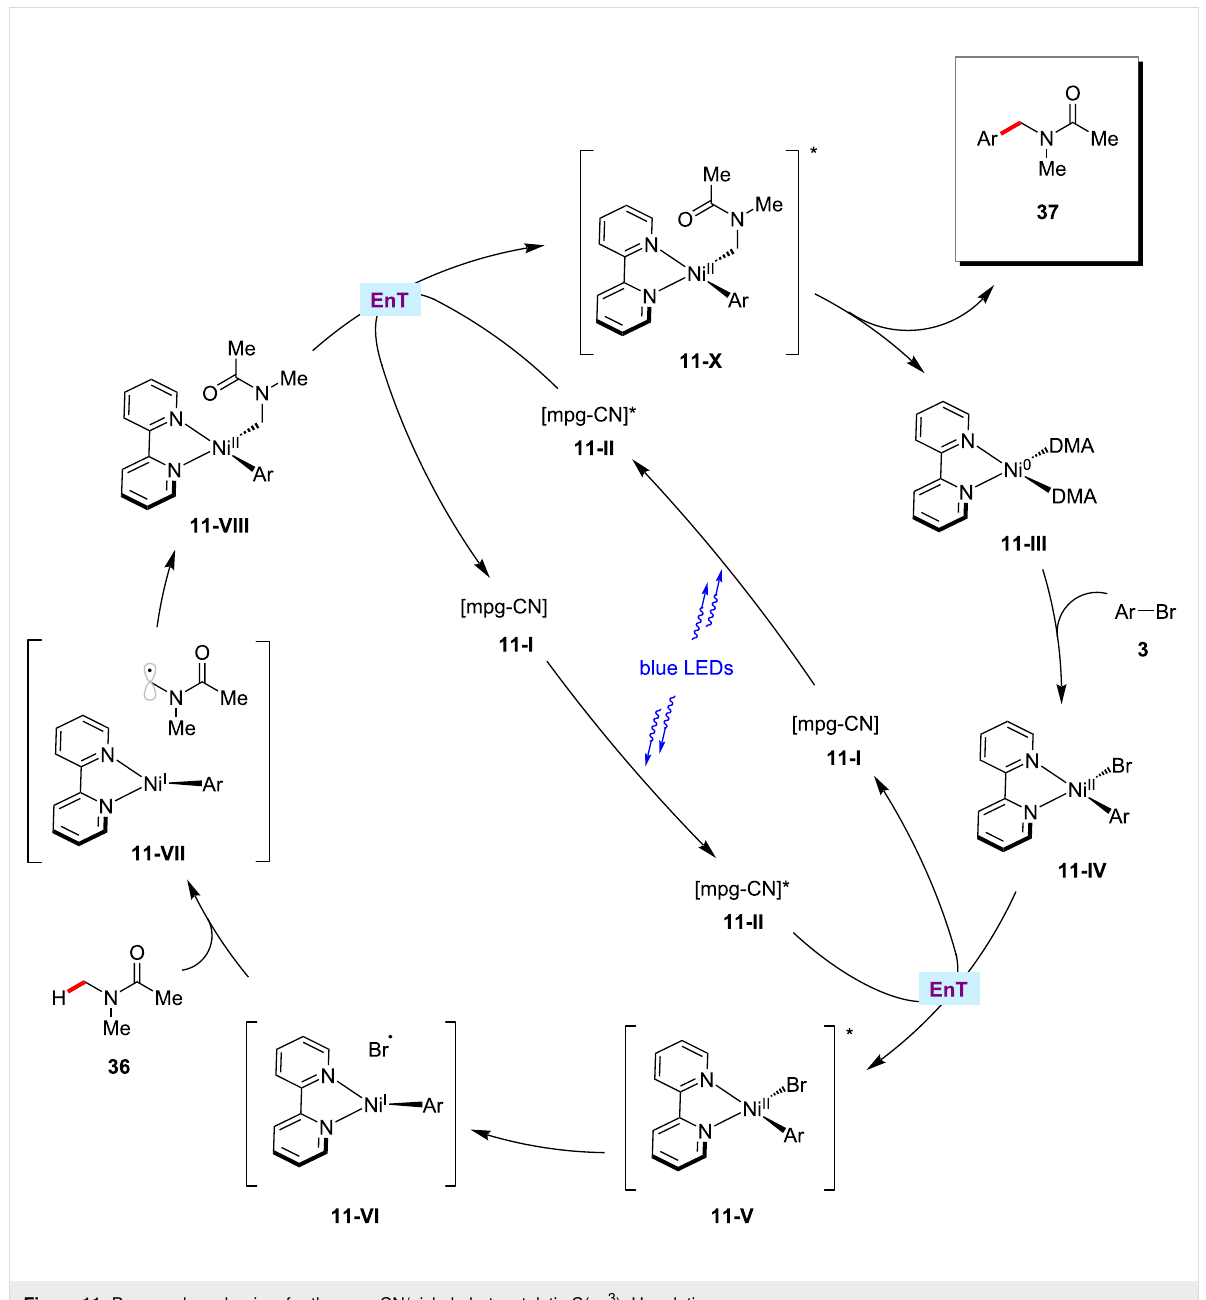
Figure 11: Proposed mechanism for the mpg-CN/nickel photocatalytic C(sp 3 )–H arylation.